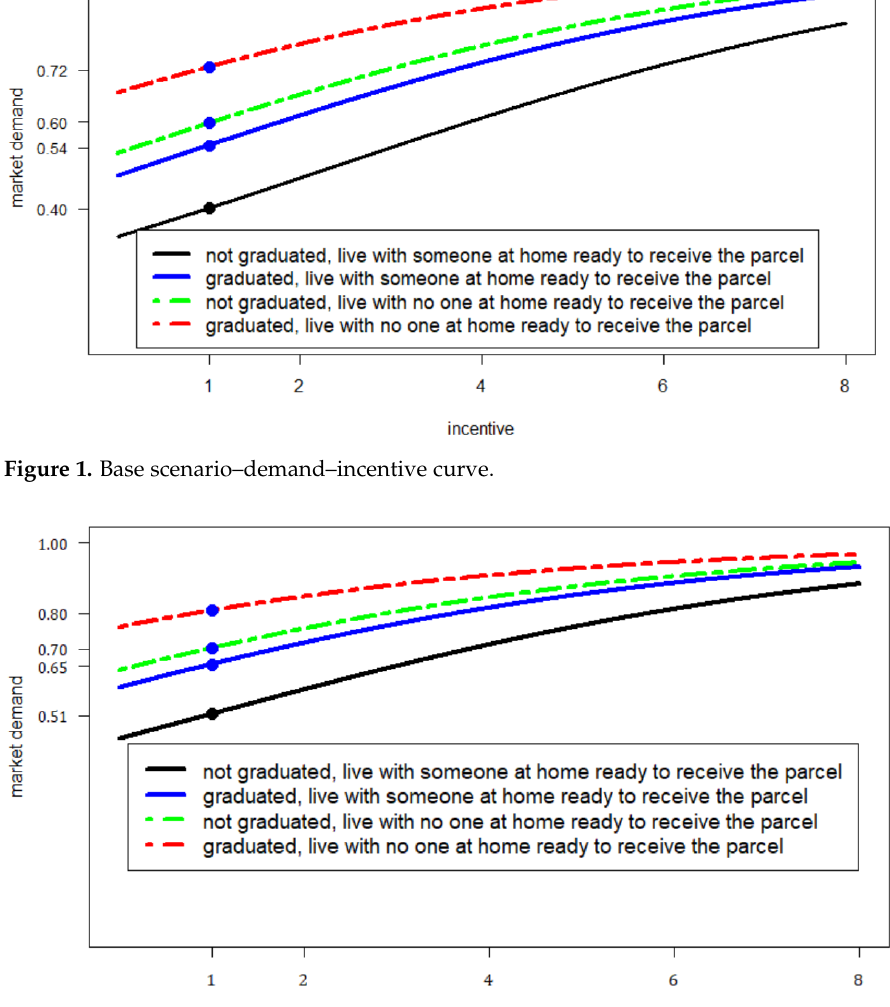
Figure 2. Scenario I–base scenario with h24 accessibility.